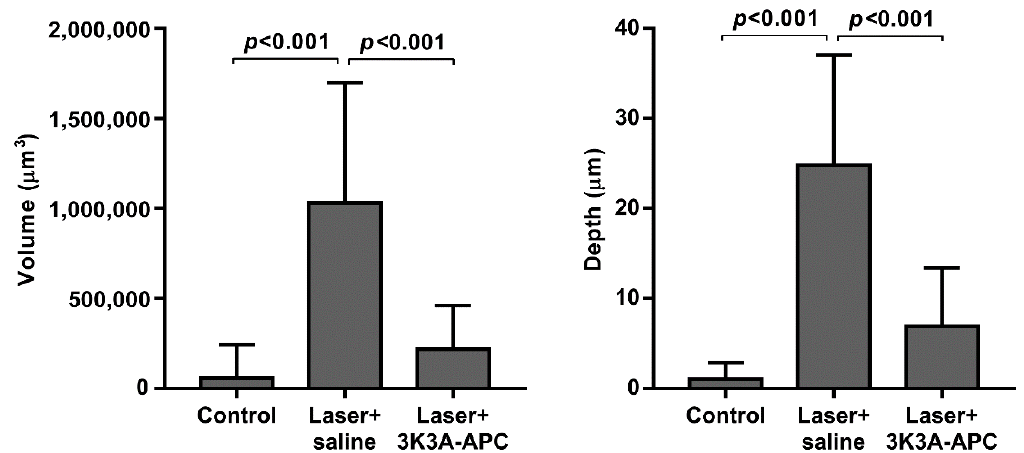
Figure 3. 3K3A-APC induced regression of CNV. Six days post laser, CNV presence was confirmed by FA, and mice were injected ITV with 1 µ g/ µ L 3K3A-APC or with saline. Mice without laser application were injected with saline and served as a control. Seven days later, blood vessels were stained using FITC-dextran perfusion, choroidal flatmounts were isolated, and 3D confocal images were scanned. Quantification of the depth ( µ m) and the volume ( µ m 3 ) of the CNV was measured using Imaris. The data are presented as mean ± SD (7–9 mice per group) and were analyzed using one-way ANOVA followed by Tukey post hoc test.